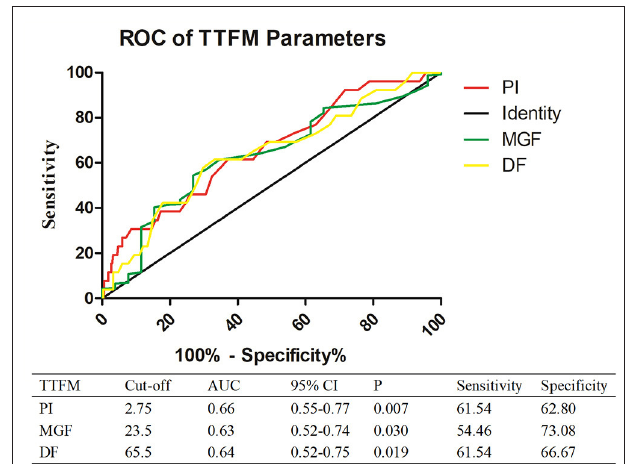
FIGURE 2 | Comparison of TTFM parameters between the patent and occluded groups.